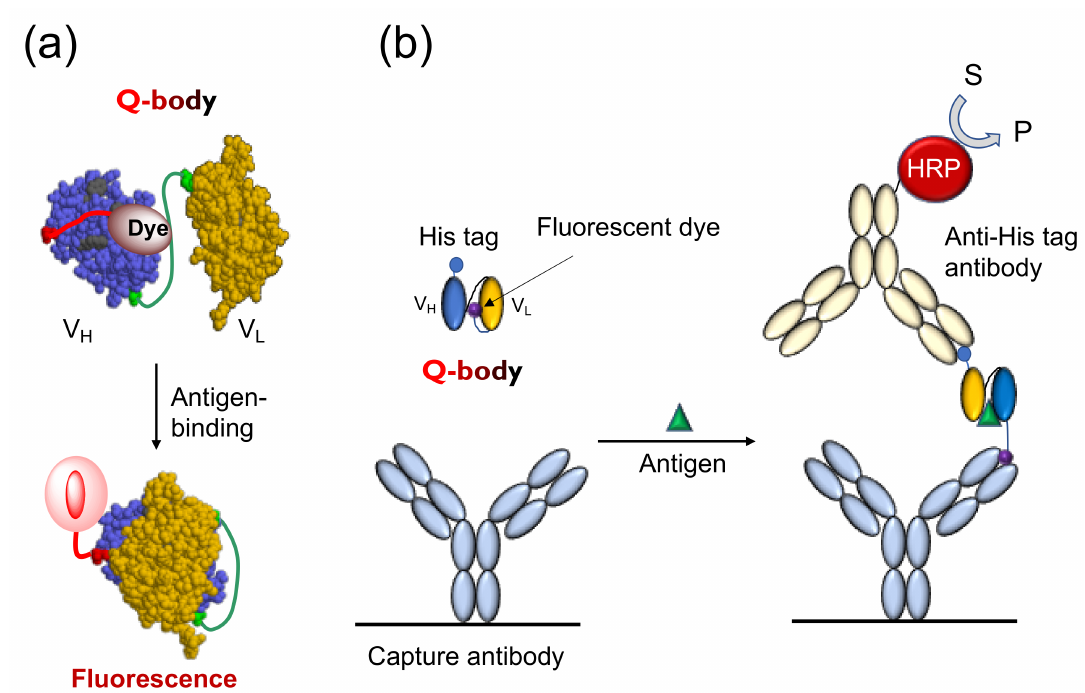
Figure 1. The working mechanism of Quenchbody. ( a ) The working model of Quenchbody. Trp residues are shown in light green.; ( b ) An ELISA to demonstrate the movement of the fluorescent dye on Quenchbody